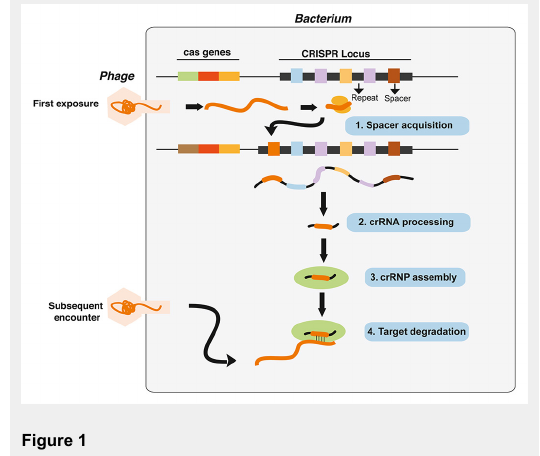
CRISPR directed antiviral immunity in bacteria. An outline of how CRISPR-mediate antiviral immunity functions in bacteria. Upon defective viral infection, short viral sequences are inserted into the CRISPR array, where they become the new “spacers” flanked by repeats. The spacers, thus provide a memory of past infection. To ensure immunity to subsequent infection, the entire CRISPR array is transcribed and processed into short crisprRNAs (crRNAs), which form complexes with other “effector” Cas proteins and guide them to degrade invading viral DNA or RNA in a sequence-specific